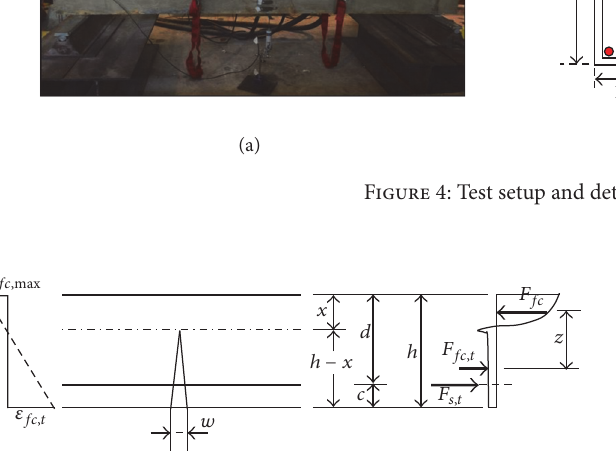
Figure 7: Strain diagram of R-ECC according to